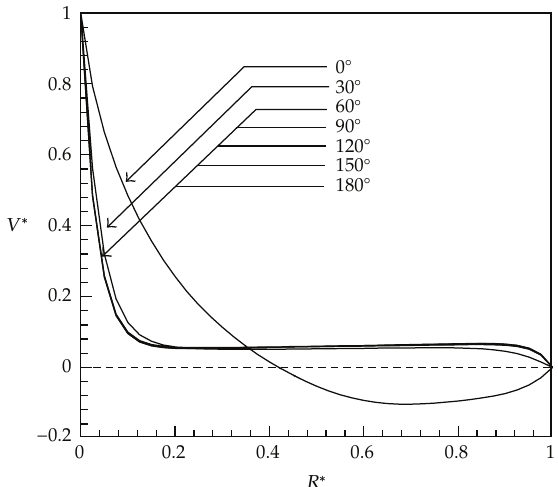
Figure 6: Angular velocity profiles at 0 ◦ ≤ θ ≤ 180 ◦ subjected to a semicircular external magnetic field.